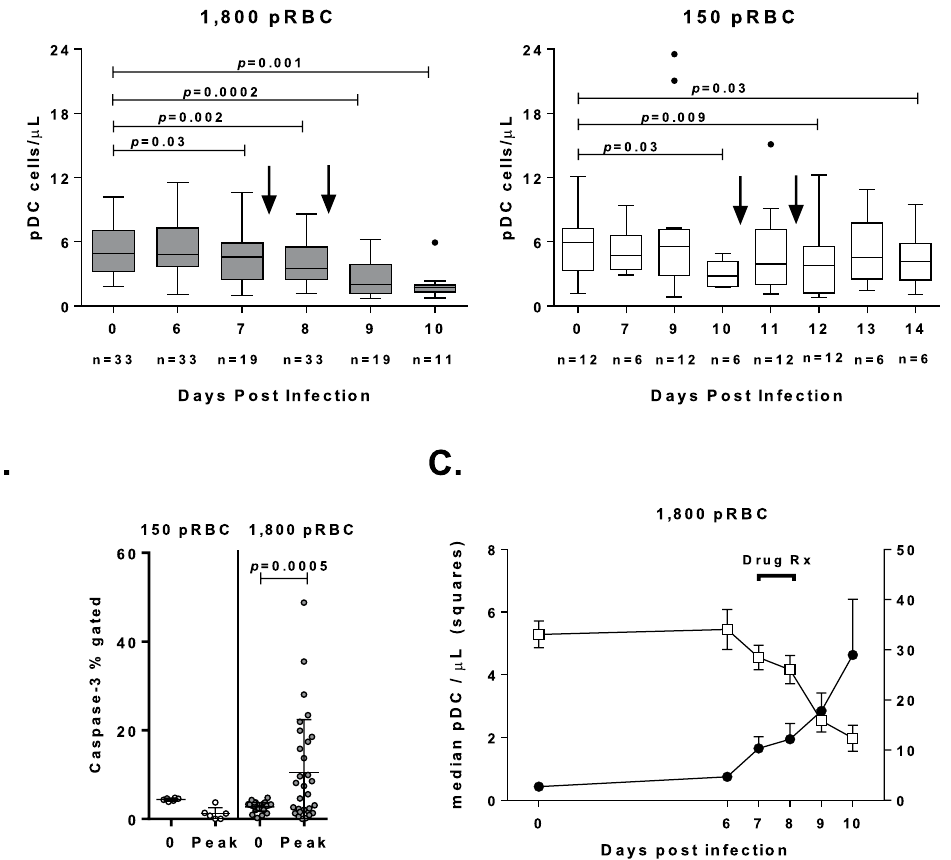
Figure 3. Increased pDC active caspase-3 detection. ( A ) The absolute number of circulating pDC after 1,800 pRBC infection; arrows indicate day of antimalarial treatment (n = 9 (day 7), n = 24 (day 8)). The absolute number of circulating pDC after 150 pRBC infection; arrows indicate day of antimalarial treatment (n = 1 (day 10), n = 11 (day 11)). Box plots show the minimum, maximum, median and interquartile range for data from all participants (turkey plot). Data points outside of box plots represent patients which were outliers. The number of individual data points for each day is given below the x-axis. ( B ) Percentage of pDC positive for active caspase-3 after 150 pRBC (n = 6, open circles) or 1,800 pRBC (n = 30, closed circles) infection. The horizontal line and whiskers represent the median and inter-quartile range, Wilcoxon matched-paired test was used for comparison between day 0 and day 7–8 (peak) or day 10–11 (peak). ( C ) Mean ( + / − SEM) number of circulating pDC (white squares) and proportion of active caspase-3 positive pDC (black circles) after 1,800 pRBC infection n = 30. Abbreviations: FSC, forward scatter SSC, side scatter, MFI, median fluorescence intensity, SEM, standard error of the